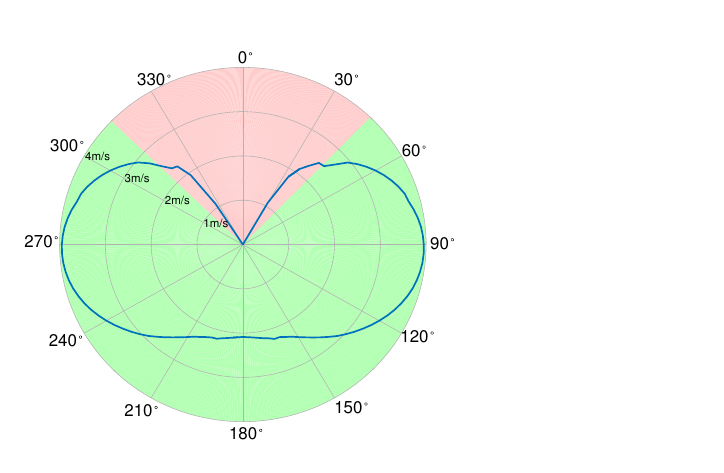
Figure 4. The relationship between the windward angle and maximum forward speed of a sailboat.